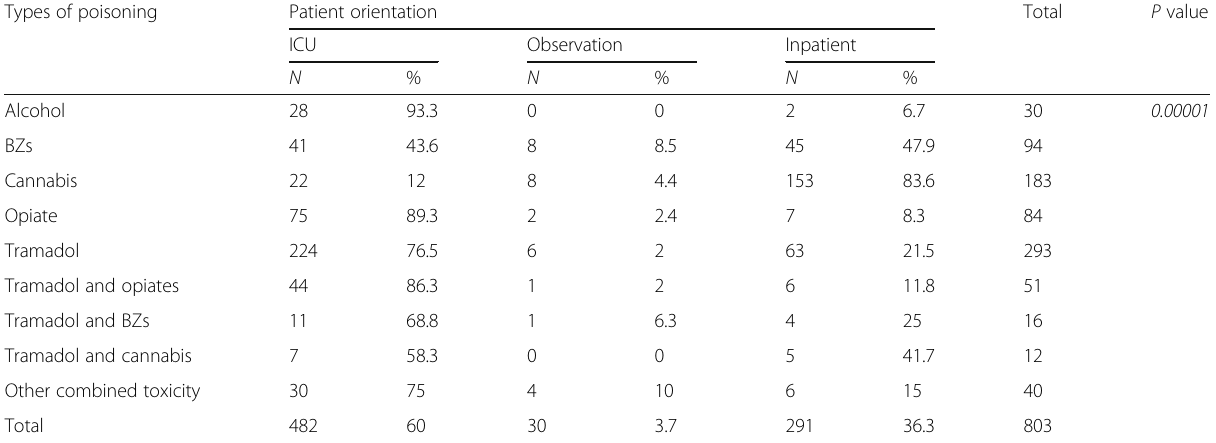
Table 8 Different sites of patient admission among each type of poisoning Types of poisoning